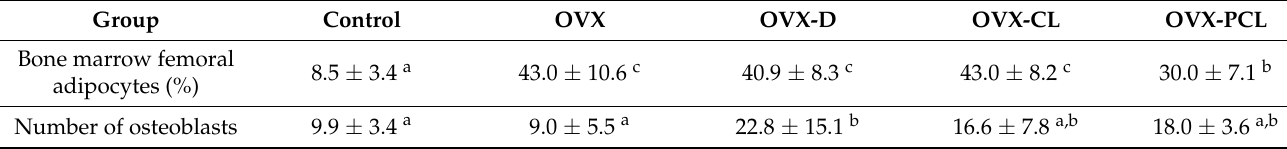
Table 3. Percentage of bone marrow femoral adipocytes and the number of osteoblasts (mean and standard deviation). Group Bone marrow femoral